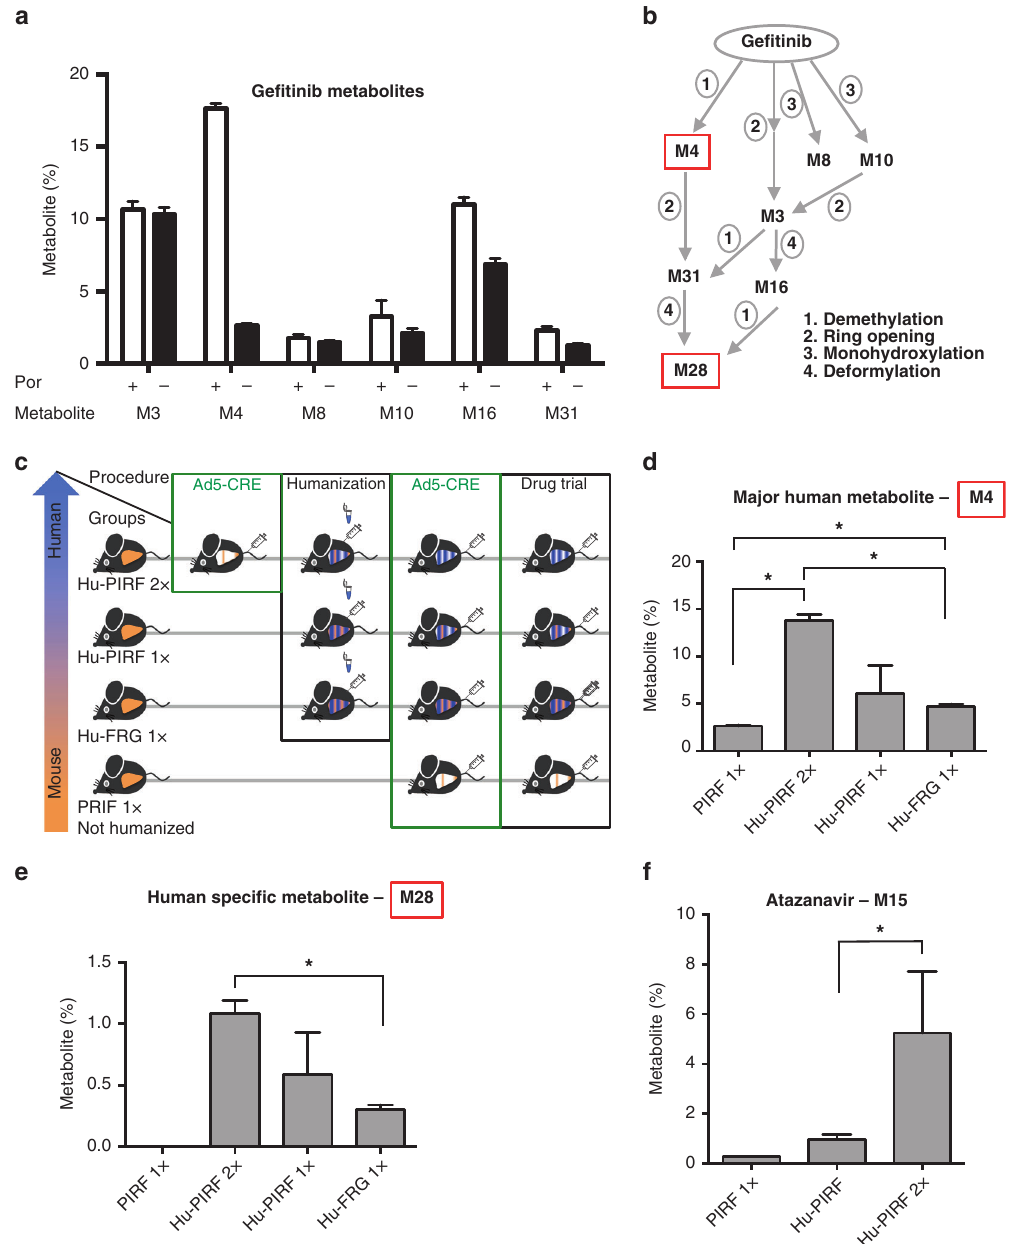
Fig. 4 Xenobiotic metabolism in humanized PIRF mice. Mass spectrometry analysis of murine feces within 16 h after intravenous injection of ge fi tinib a cancer therapeutic. a Selection of abundant and decreased ge fi tinib metabolites upon murine P450 oxidoreductase ( Por ) deletion in non-humanized PIRF mice ( N = 3). b Ge fi tinib metabolites and known biotransformation. c Experimental setup: not-humanized PIRF mice and Humanized (Hu) FIRF and FRG mice were injected once (1x, after transplantation of human hepatocytes) or twice (2x, before transplantation and after reaching high human chimerism) before doing drug studies. All experimental groups contain three animals, if humanized, with high ( > 70%) and similar human chimerism (see Methods). Murine Por -deleted, human liver chimeric PIRF (Hu-PIRF 2x) mice show the most abundant human metabolite, M4 d , and the human-speci fi c metabolite M28 e of ge fi tinib ( N = 3). f Mass spectrometry analysis of PIRF liver homogenates 30 min after injection of atazanavir, a retroviral therapeutic. A major human metabolite (M15) is shown. The overall abundance of metabolites from atazanavir or ge fi tinib was set as 100% in each sample. The data